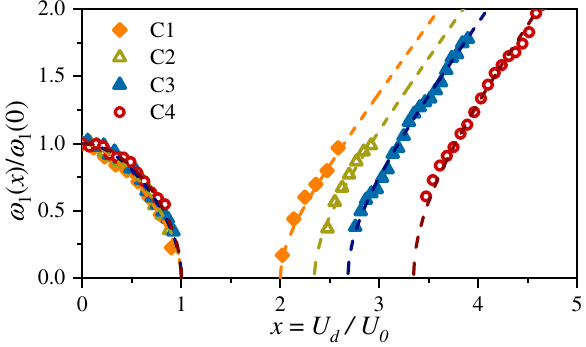
FIG. 10. The experimental results showing the resonant fre- quency versus drain voltage bias in normalized scales. Dotted lines show results of calculations according to Eq. (10).